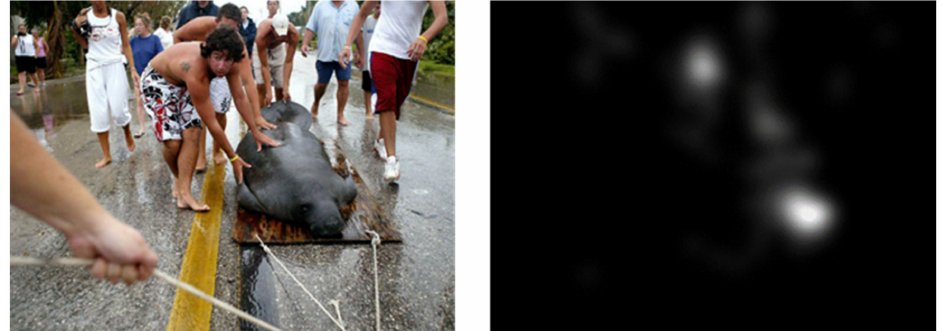
Figure 5. An animal in the picture attracting more attention than